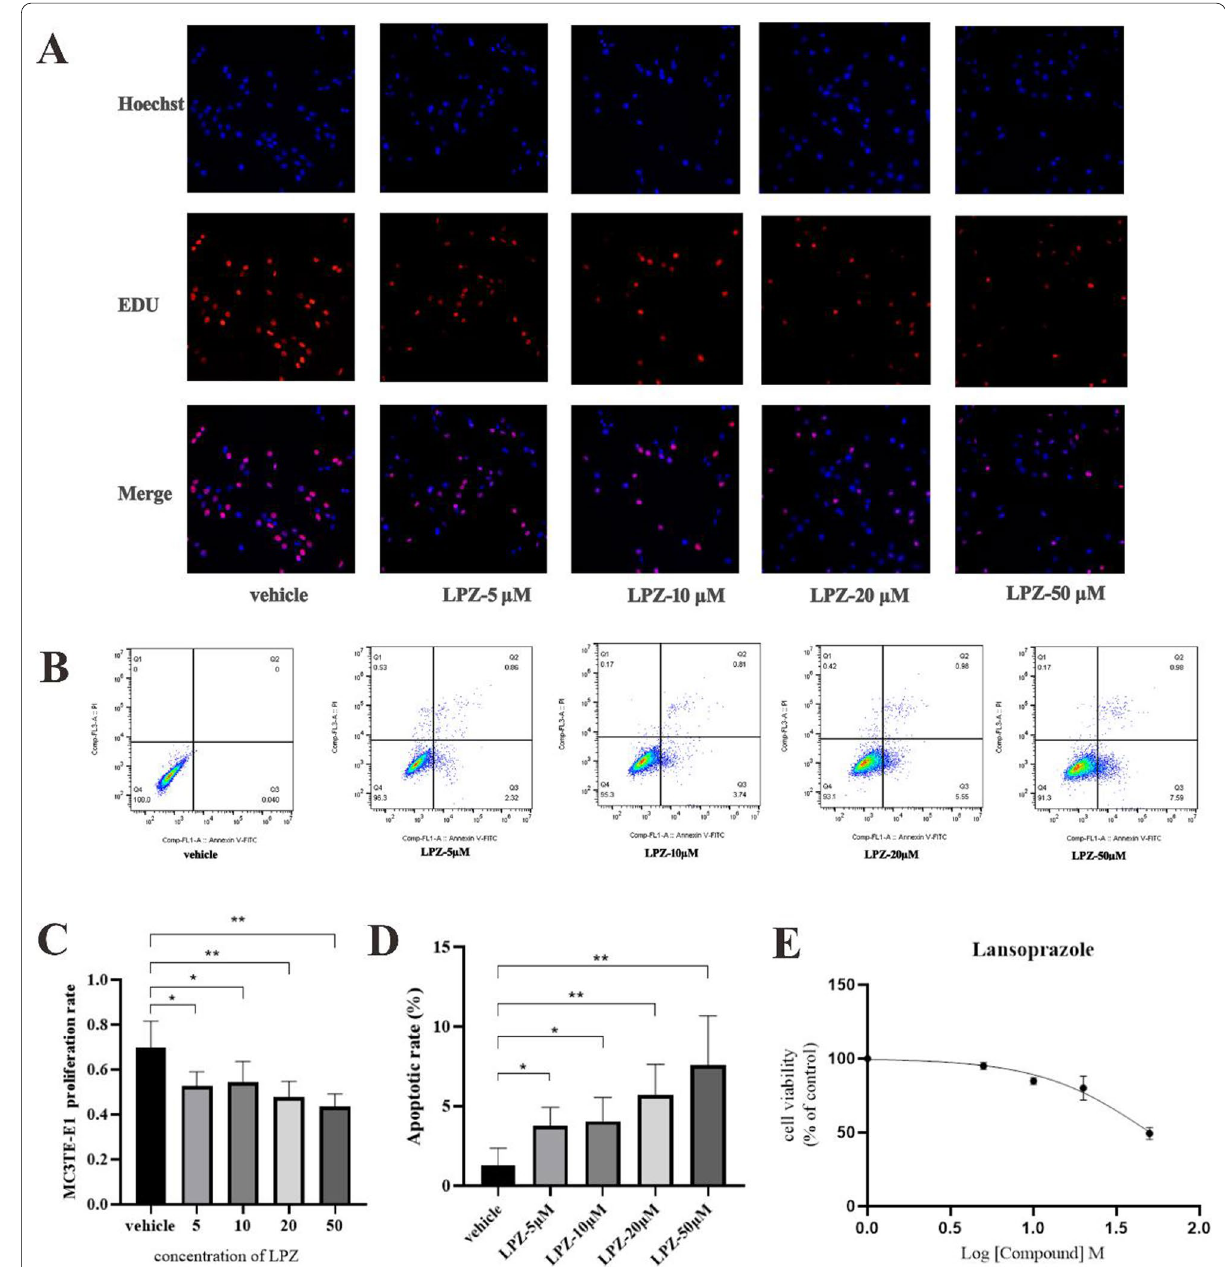
Fig. 3 Cell proliferation, viability and apoptosis were examined by CCK-8 assays, EdU assays and flow cytometry. A MC3T3-E1 cells were treated with increasing concentrations of LPZ, and the EdU assay showed a reduction in proliferation. B Apoptosis in osteoblasts pretreated with LPZ (0, 5, 10, 20, 50 µM) for 24 h. C Number of cells, as determined by the EdU assays. D Quantitative analysis of apoptotic rates. E The viability of MC3T3-E1 cells after LPZ treatment. * P < 0.05, ** P < 0.01 (n =